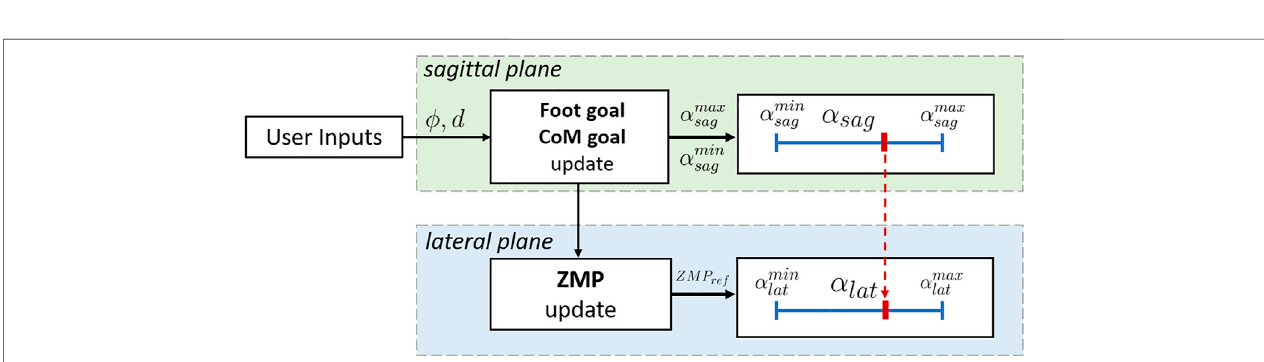
FIGURE 3 | A snapshot of the preview window (in black) and the ZMP future reference (in blue) during a step. The advancement of the preview window does not depend on time, but it is bound to the evolution of the phase variable α lat from α min lat to α max lat .